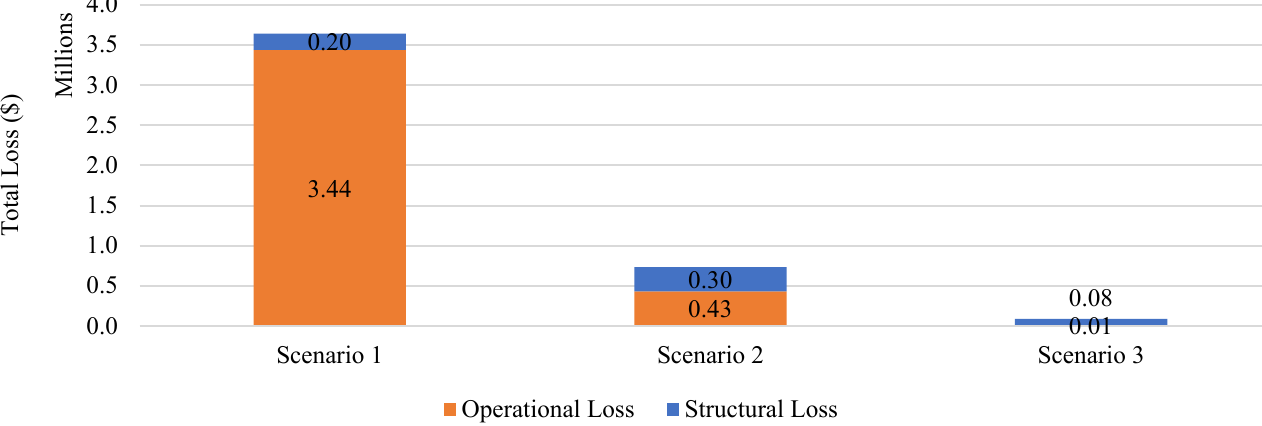
Figure 15. Total loss for three different scenarios.